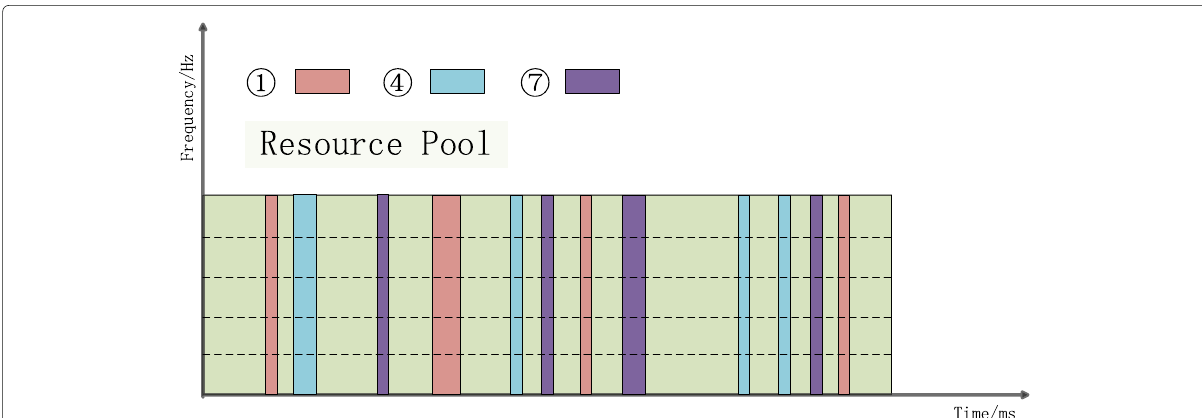
Fig. 7 Resource pool partition. Numbers in the figure are the labels of sub resource pools. Subframes of each sub resource pool are randomly